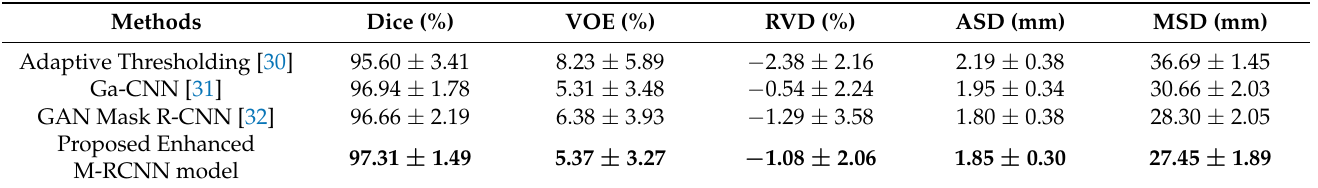
Table 2. The results of a quantitative comparison with approaches on 20 Sliver07-Training datasets. Dice